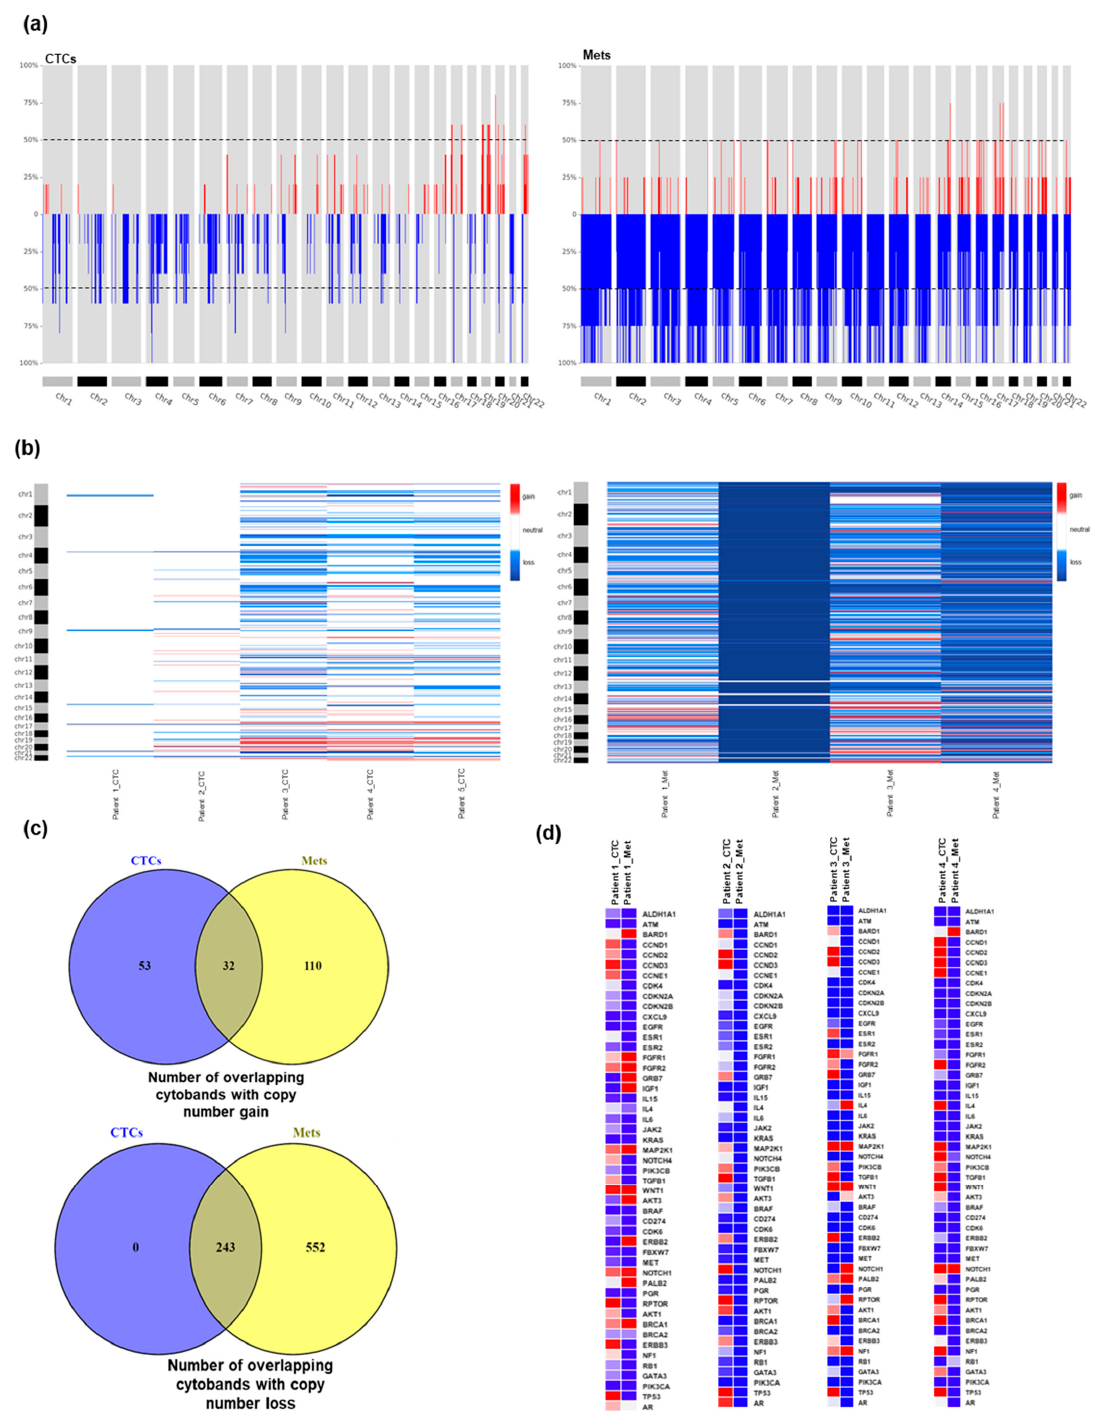
Figure 4. Overview of copy number alterations (CNAs) in CTCs and matched metastatic tissues ( a ) Overall copy number landscape showing the high prevalence of focal alterations in all CTCs and metastases. The y-axis shows the frequencies of the occurrence of somatic gains (red) and losses (blue) in sub-cytoband regions. ( b ) Heatmap showing the segmented copy number profiles at chromosomal arm level in each of the samples in CTCs and metastases (gain = red, loss = blue, and neutral = white). ( c ) The number of overlapping cytobands depicting copy number gain and loss in CTCs and metastases. ( d ) The heatmap showing the gains and losses in 49 potentially actionable genes in CTCs and